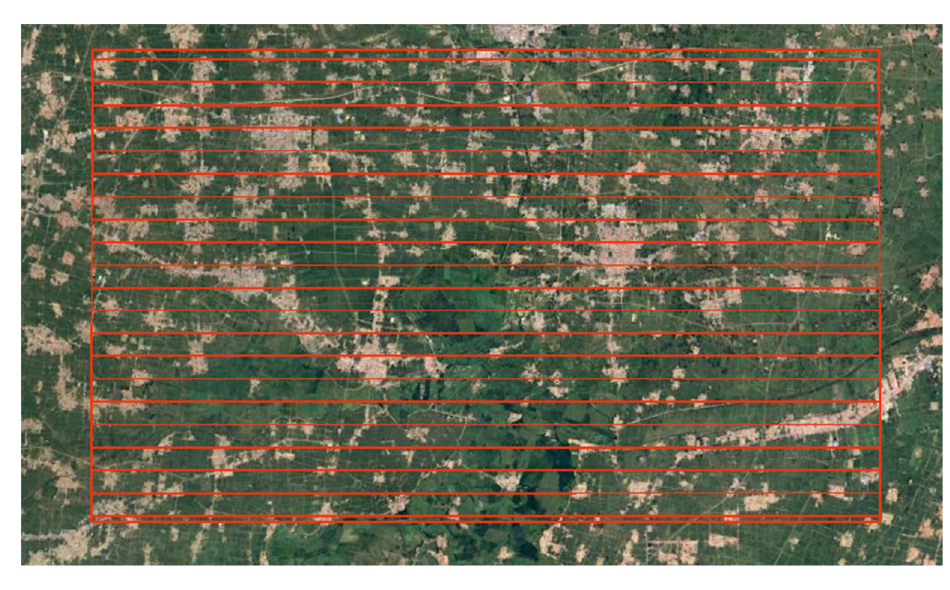
Figure 21. Air rout plan of Xiong’an City. Sensors 2019 , 19 , x FOR PEER REVIEW